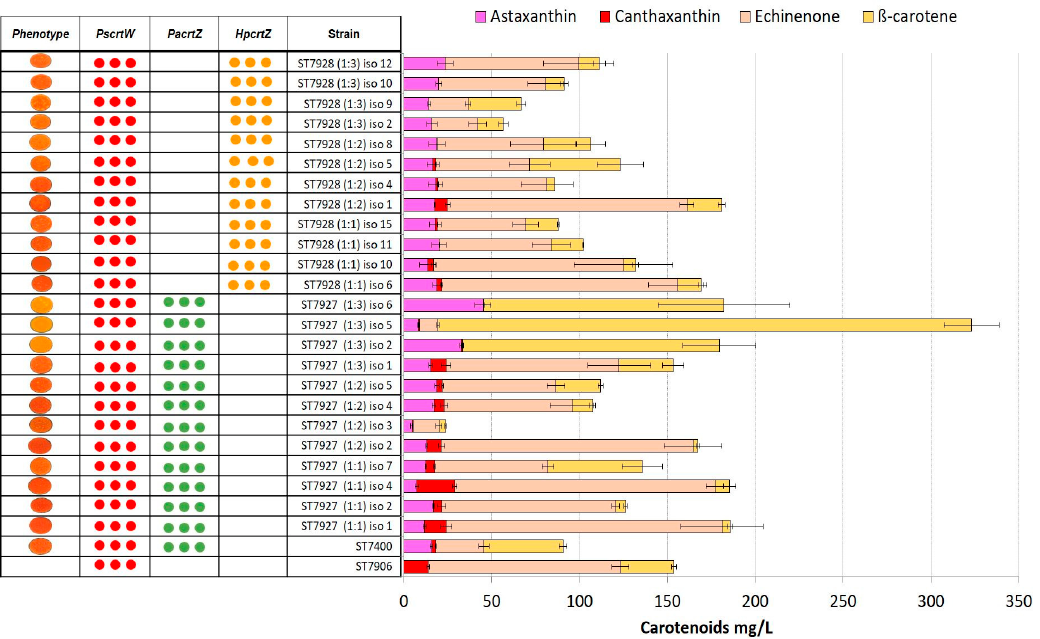
Figure 5. Carotenoid production by strains ST7927 and ST7928 transformed with combinations of PscrtW and PacrtZ / HpcrtZ genes. Molar ratios of DNA constructs are in brackets. Strains used as controls: ST7906 and ST7400. Three dots represent multiple integrations of genes. All strains were cultivated in YP + 8% glucose in 24-deep-well plates for 72 h. The error bars represent standard deviations calculated from triplicate experiments (‘iso’ after each strain indicates the isolate number).